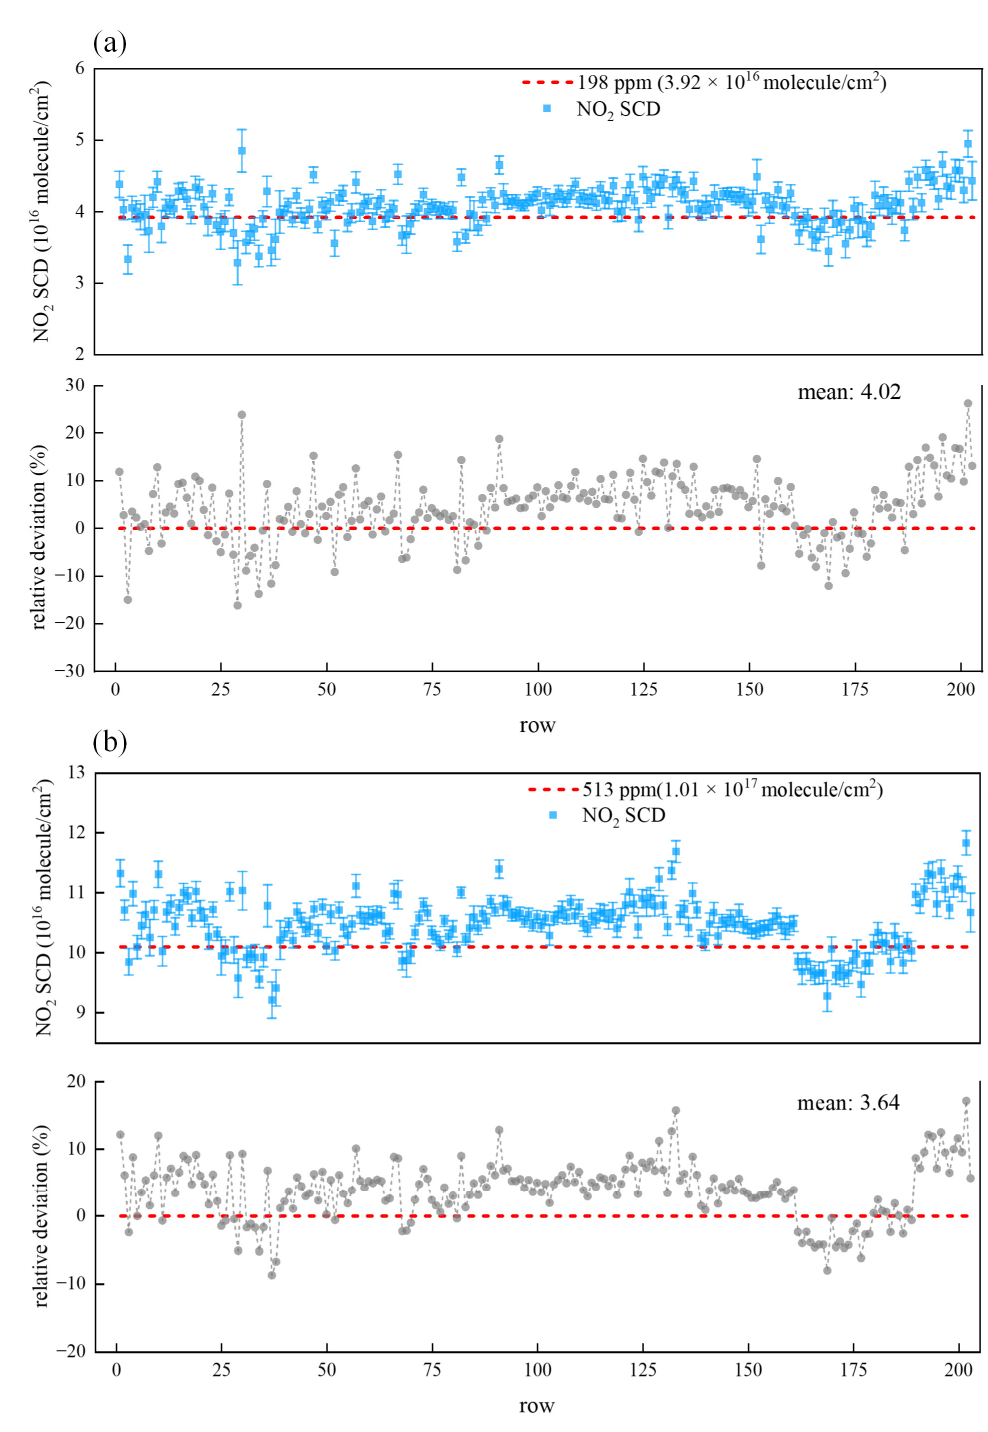
Figure 5. NO 2 SCD with fitting error and relative deviation of different spatial pixels of the EMI-NL nadir module with scattered sunlight and NO 2 sample gas concentrations of: ( a ) 198; and ( b ) 513 ppm.